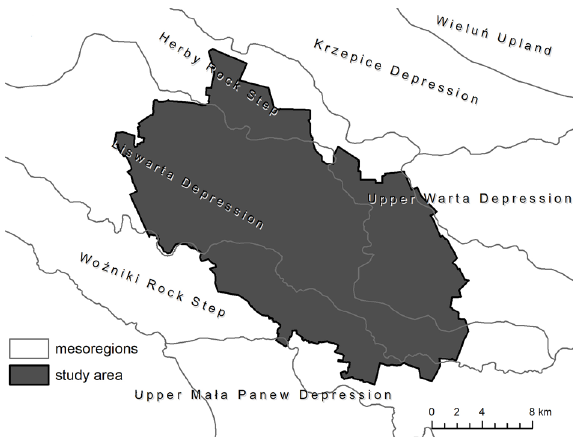
Fig. 2. Location of the Forests by Upper Liswarta Landscape Park on the background of mesoregions.